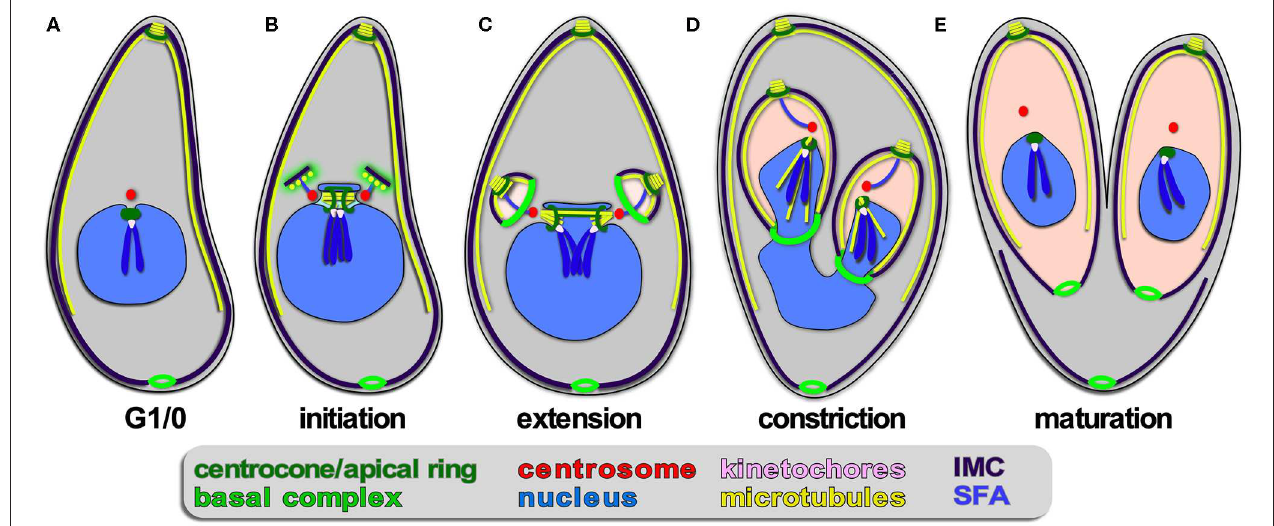
FIGURE 4 | Apicomplexan asexual cell division by endodyogeny. (A–E) Show progressive steps of cell division as observed for T. gondii tachyzoites. Two daughters bud internally, while the mother’s cytoskeleton is maintained and only destabilized just before emergence of nearly mature daughters (E) . A dark blue SFA fiber anchors the centrosomes in the apex of the daughter